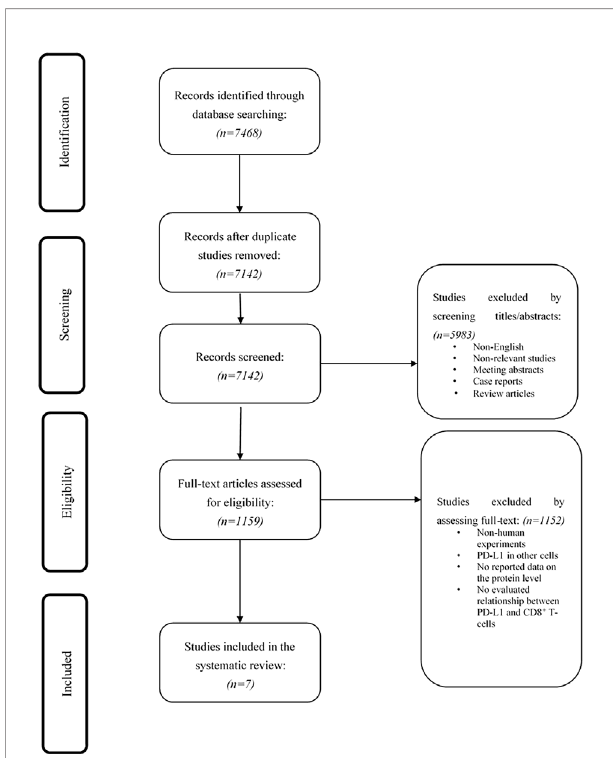
FIGURE 1 | The fl ow chart of the study selection